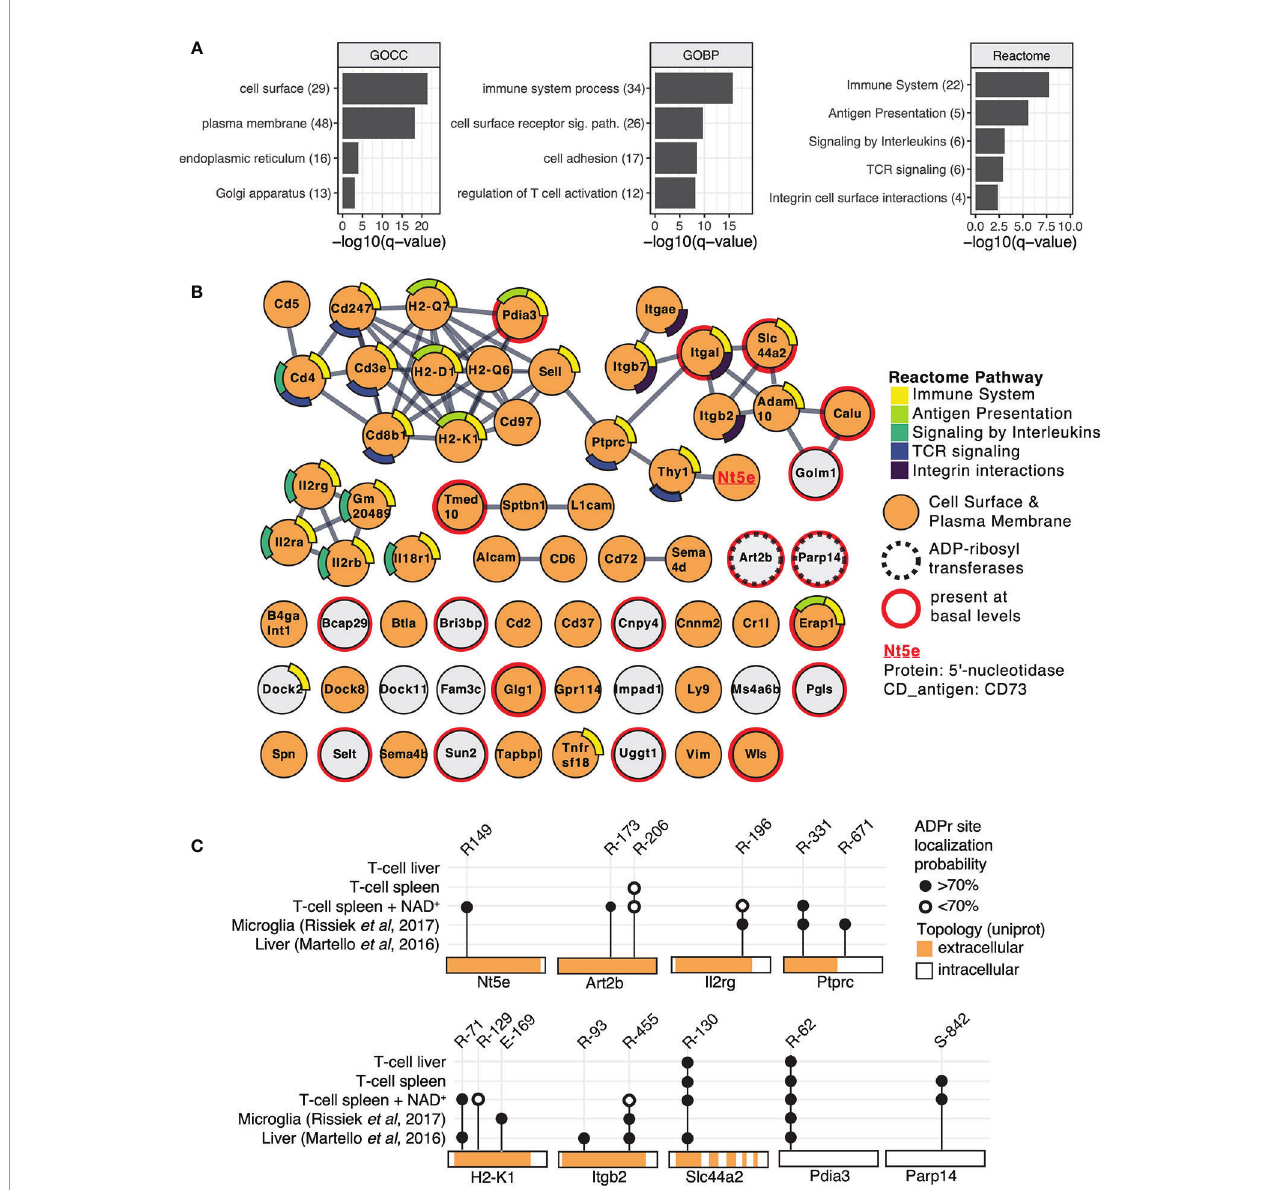
FIGURE 2 | Mouse T cell surface ADP-ribosylome analyses. (A) Gene ontology term enrichment was performed for ADP-ribosylated proteins identi fi ed in all conditions against the whole mouse genome. Gene ontology biological processes (GOBP), gene ontology cellular components (GOCC) and Reactome pathways were included. The q-values of selected and signi fi cantly enriched terms are plotted. Numbers of ADP-ribosylated proteins included in the speci fi c terms are indicated in brackets. (B) STRING protein-protein interaction network of ADP-ribosylated proteins identi fi ed in all conditions. Gene names of ADP-ribosylated proteins are shown and high con fi dence protein-protein interactions (STRING interaction score ≥ 0.9) are indicated with grey lines. Protein nodes are color coded by their af fi liation to the Reactome pathways shown in (A) Proteins associated with the plasma membrane or cell surface are marked in orange. Proteins that were already identi fi ed under untreated conditions are marked with a red line and the two identi fi ed ADP-ribosyltransferases with a dashed line. CD73 that was chosen for follow up studies is highlighted. (C) ADP-ribosylation sites on selected proteins are plotted and compared to ADP-ribosylation sites identi fi ed in (23,